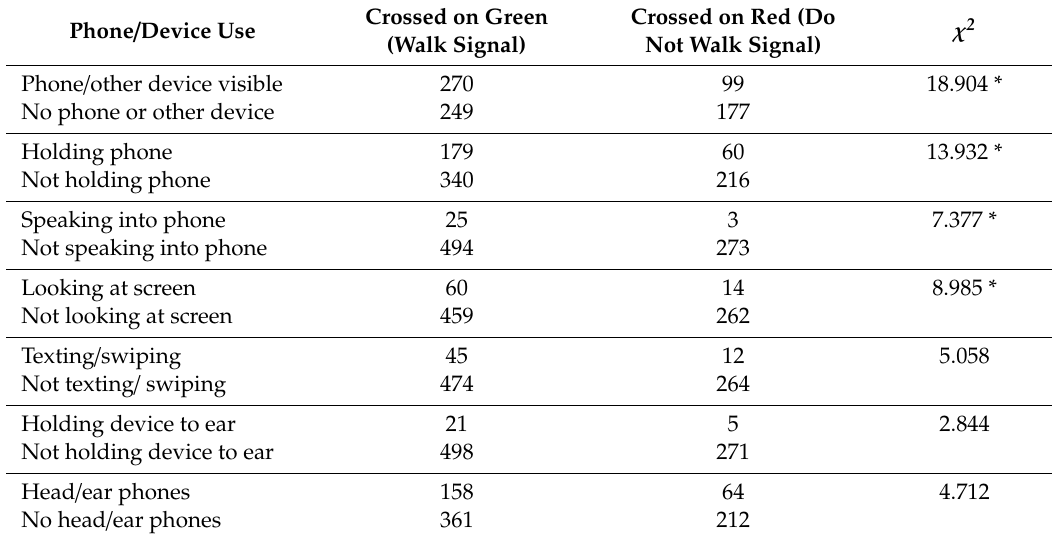
Table 2. Use of electronic devices in relation to road-crossing behaviours—walk signal (number of road